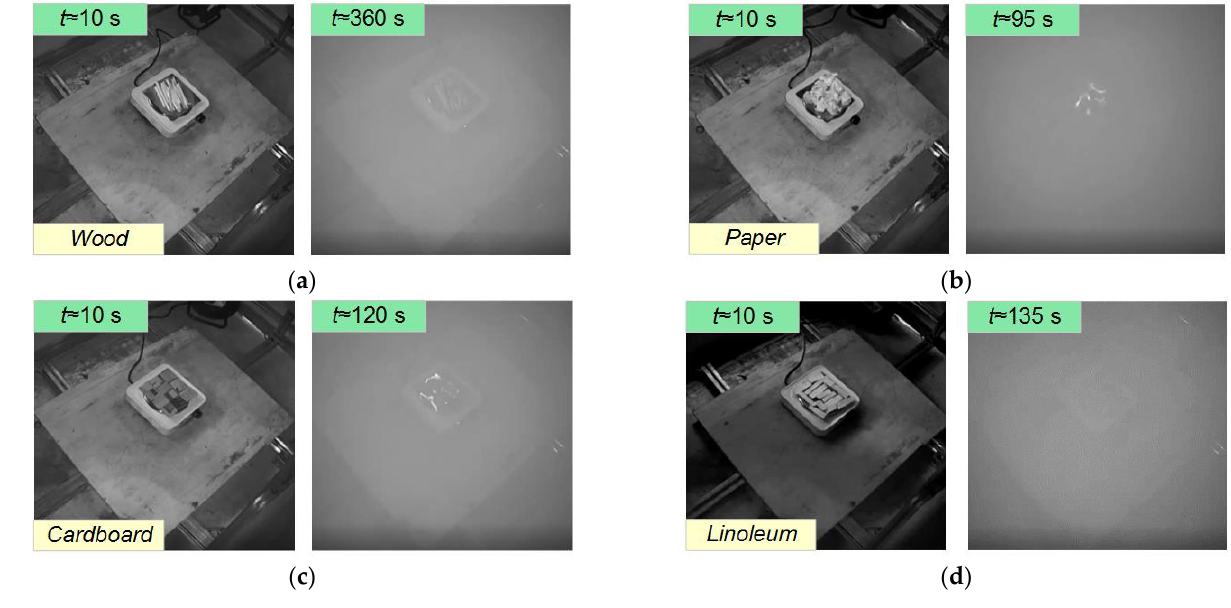
Figure 4. Images of model fire when reproducing conditions of unsafe operation of heating equipment (hot plate) at the stages (from left to right) of heating, pyrolysis start and rapid smoke generation: ( a ) wood; ( b ) paper; ( c ) cardboard; ( d ) linoleum.